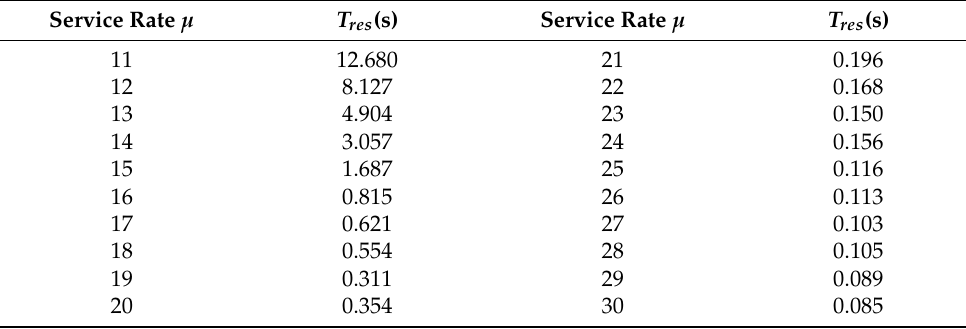
Table 4. Average response times of the M t / M /1/ K queueing